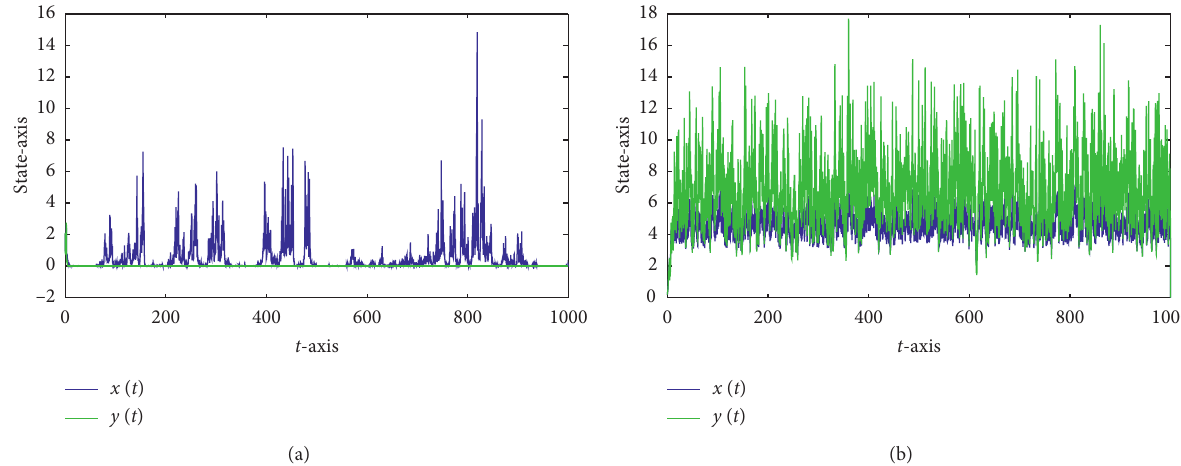
Figure 1: The effect of switching π on the dynamics of (39) and (40). (a) The nonstochastic permanence of (39) and (40) with π � ( 0 . 1 , 0 . 9 ) . (b) The stochastic permanence of (39) and (40) with π � ( 0 . 1 , 0 . 9 ) .